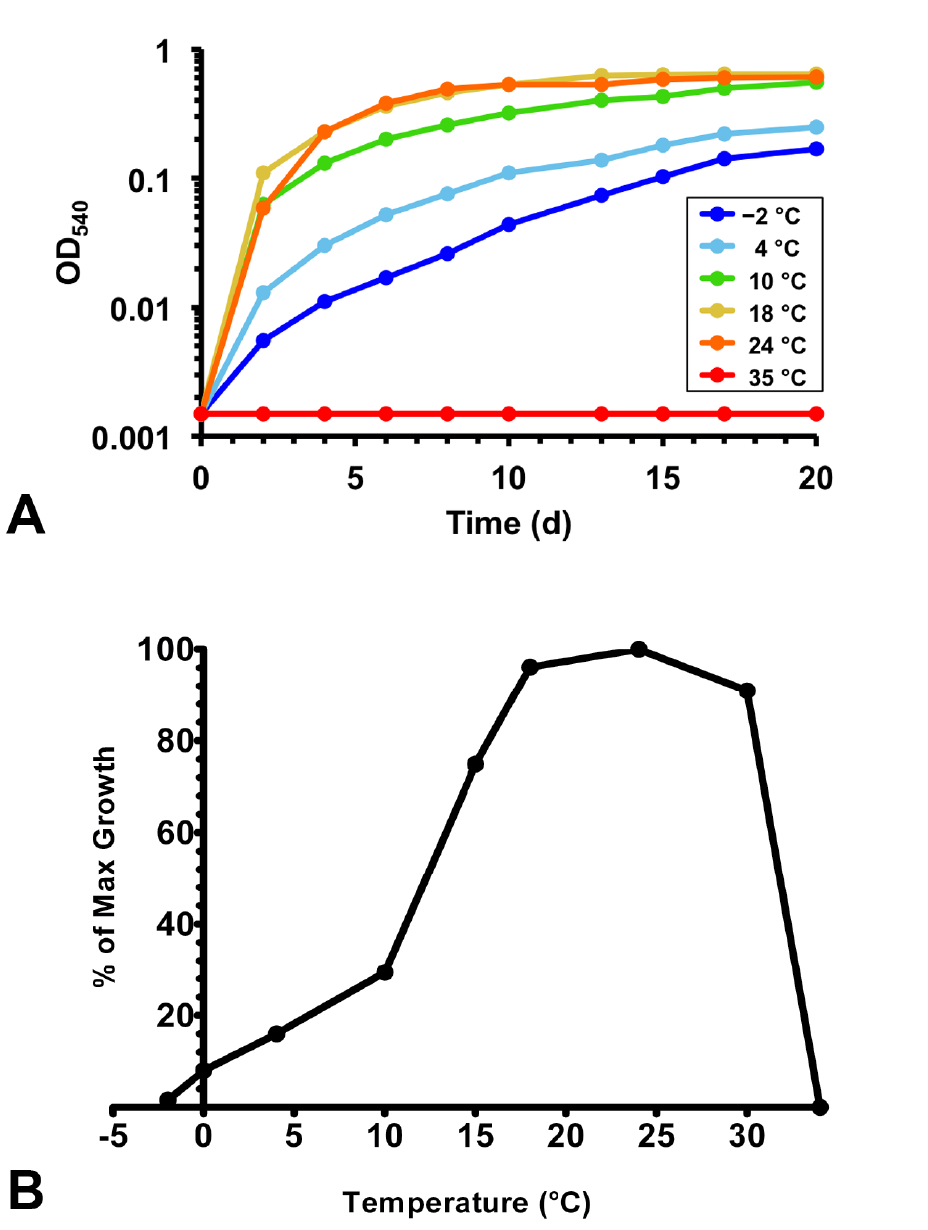
Figure 4. Growth response to temperature for Lake Vanda strain BYV50. ( A ) Growth of strain BYV50 over a range of temperatures in medium R2A containing 0.5% NaCl. Slow growth at −2 °C occurred, while no growth was observed at 35 °C; ( B ) Expression of growth rate data as percent maximum growth. Optical densities for triplicate cultures at each temperature were averaged following growth for seven days. The highest density was assigned a value of 100, and the percentage of maximum growth was calculated for each remaining